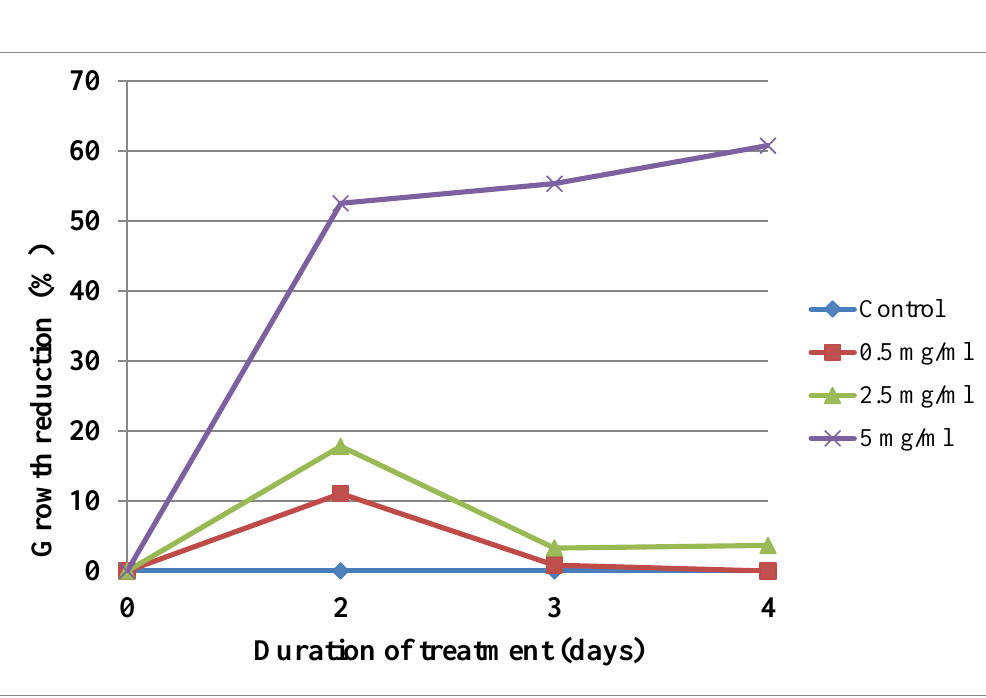
Figure 4. The effect of the extract from shoots of in vivo plant Eryngium alpinum L. [0.5 mg/mL, 2.5 Figure 4. The e ff ect of the extract from shoots of in vivo plant Eryngium alpinum L. [0.5 mg / mL, 2.5 mg/mL, 5 mg/mL] on inhibition of Acanthamoeba trophozoites proliferation in the culture medium. mg / mL, 5 mg / mL] on inhibition of Acanthamoeba trophozoites proliferation in the culture Table 4. The effect of the extract from in vitro shoot cultures of Eryngium alpinum L. [0.5 mg/mL, 2.5 mg/mL, 5 mg/mL] on inhibition of Acanthamoeba trophozoites during four days of treatment.